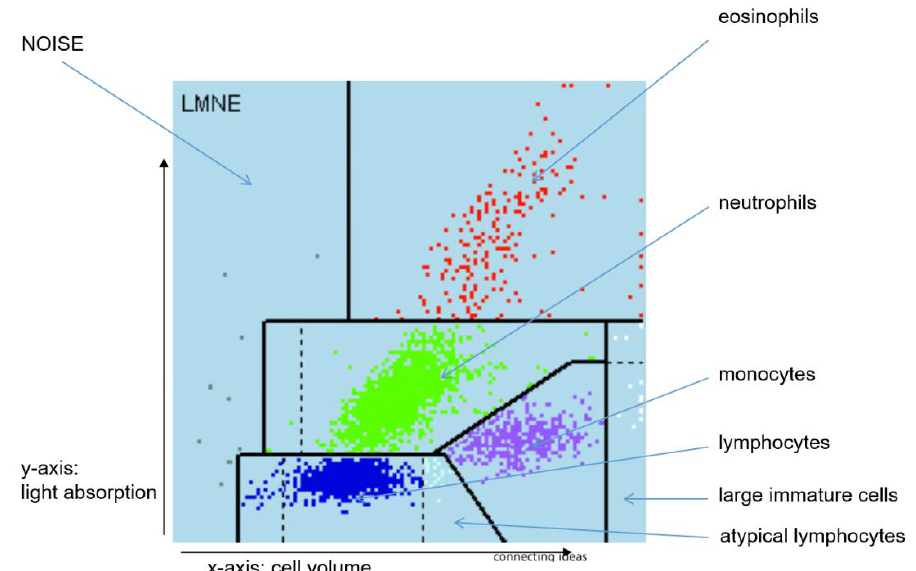
Figure 1. LMNE matrix with the different fields for the leukocyte populations and the NOISE area.